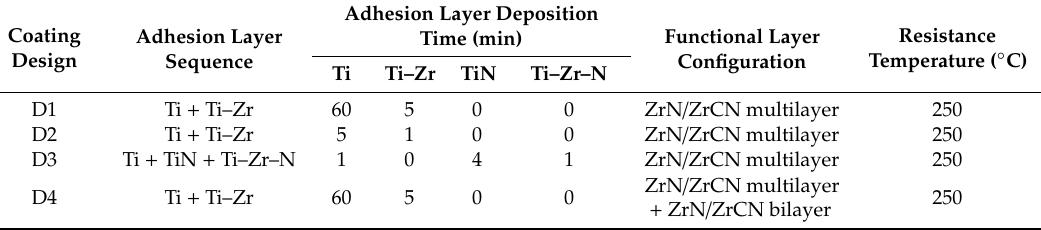
Table 2. Composition of PVD coating